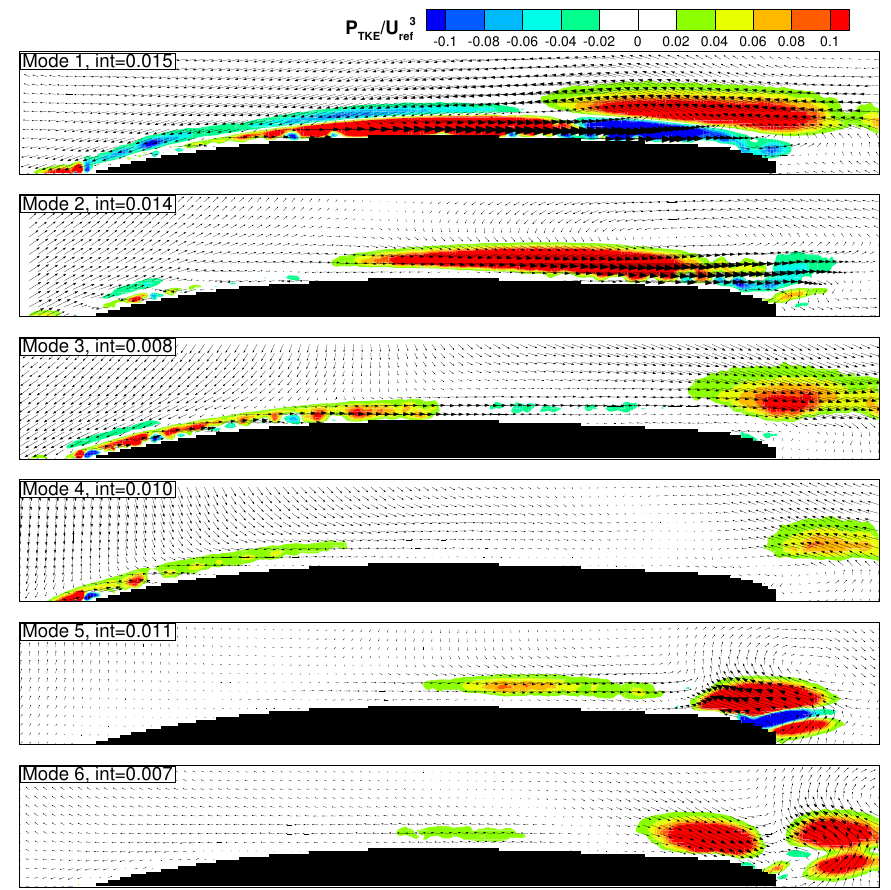
Figure 10. Turbulence kinetic energy production rate per POD mode, halved f +